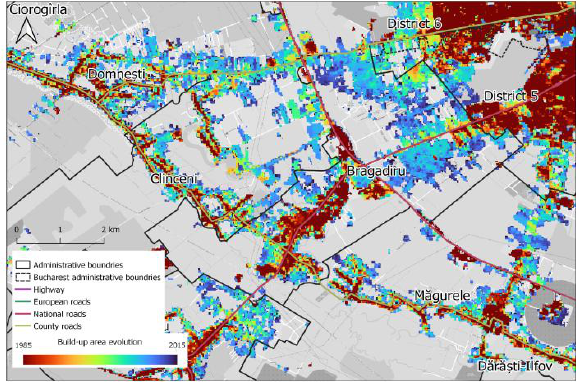
Figure 13 . Urban expansion of Bucharest between 1985 and 2015 - South (data source: WSF Evolution, DLR, CC-BY 4.0; base map: © OpenStreetMap contributors)